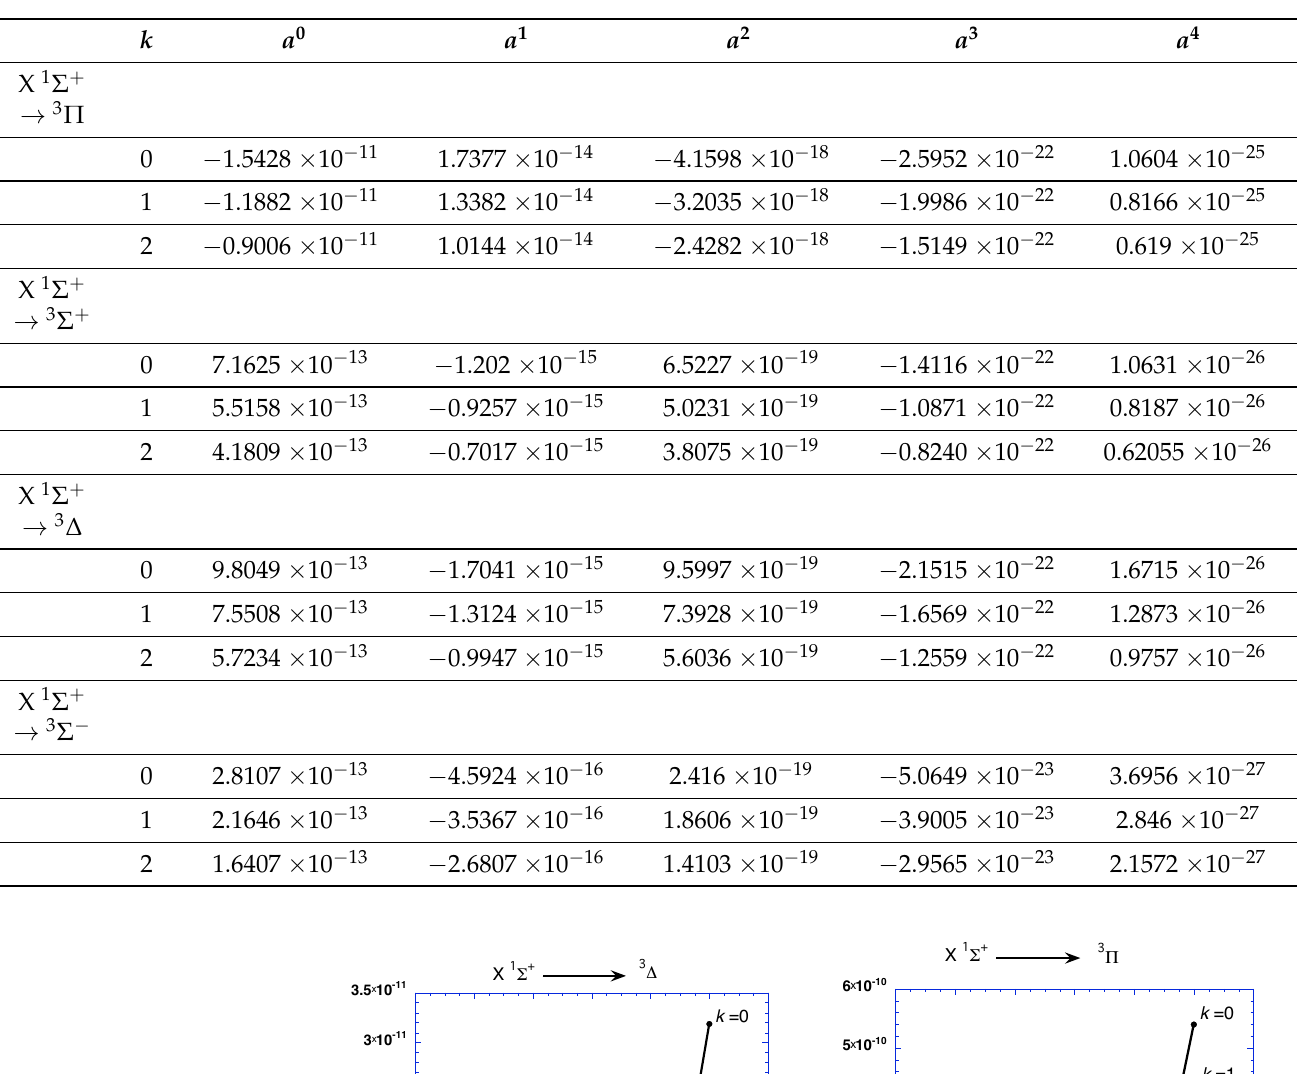
Table 1. Coefficients a 0 , a 1 , a 2 , a 3 and a 4 of Equation (2).